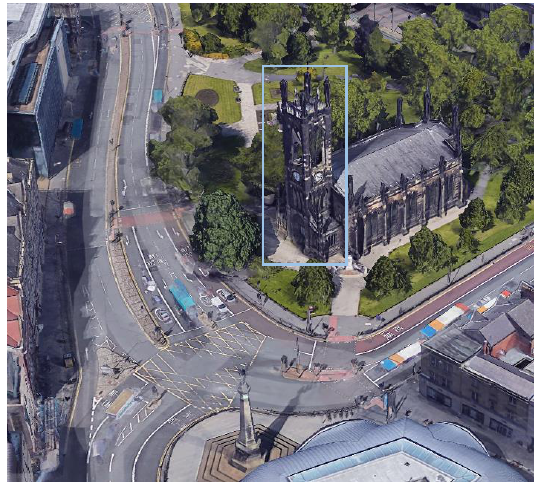
Figure 1. Google Earth 3D model of the Church and the surrounding area (Accessed 31/03/2017)